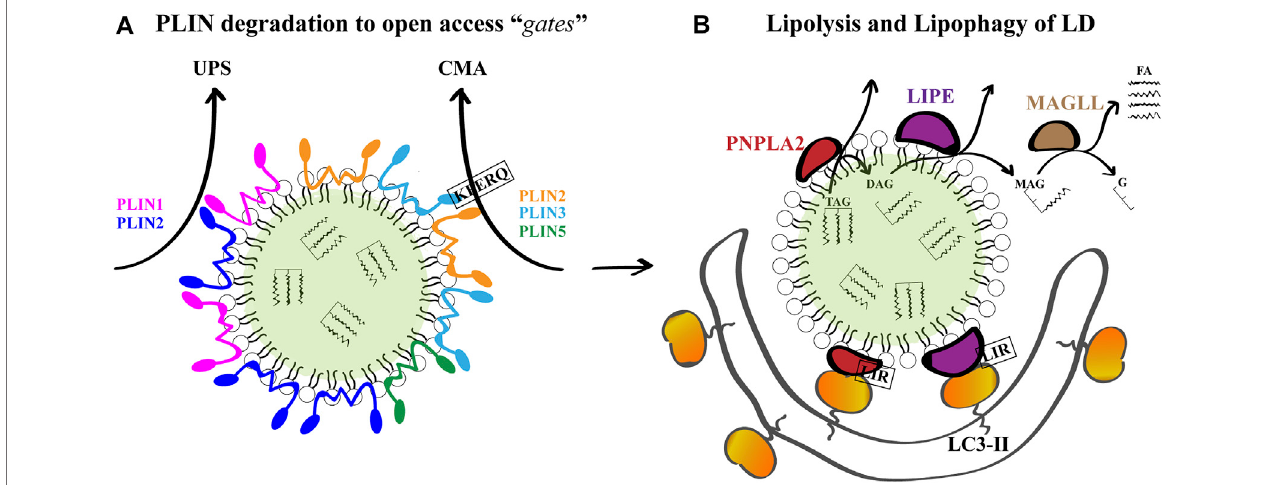
FIGURE2| LDBreakdown. (A) GiventhatPLINsaregatekeepersofLDbreakdownandfurtherlipolysis,theymustbedegradedforbreakdowntoproceed. PLIN1 and PLIN2 are substrates of the ubiquitin-proteasome system (UPS), and PLIN2, PLIN3 and PLIN5 are substrates of chaperone mediated autophagy (CMA) under conditions of lipid demand. For PLIN2 and PLIN3, a KFERQ peptide has been demonstrated to mediate CMA. (B) The degradation of LD TAG and SE occurs by the sequential action of PNPLA2, LIPE and MGLL to produce glycerol (G) and free FA for further β -oxidation. Concomitantly, PNPLA2 and LIPE located on the LD surface can interact with LC3-II on phagophore membranes through their LC3 interacting regions (LIR) to promote lipophagy-mediated LD breakdown.